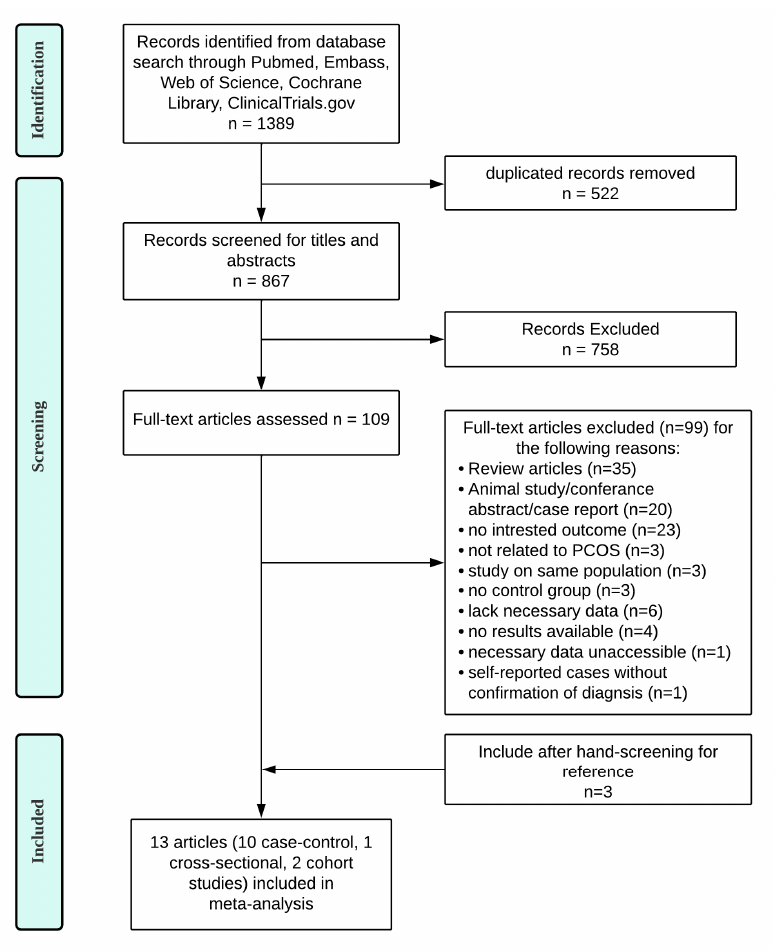
Figure 1. Flow diagram of the literature search.